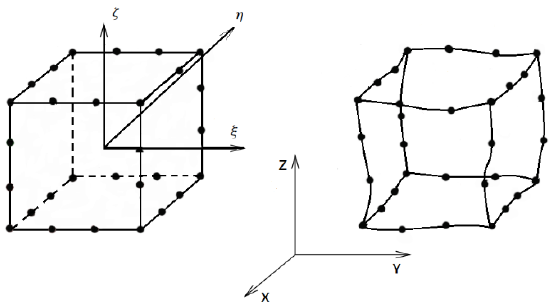
Figure A5. Cartesian global and local curvilinear coordinates of the third-order 32-node serendipity brick FE. Table A5. The shape functions of the third-order 32-node serendipity brick FE. Corner Nodes (8×)